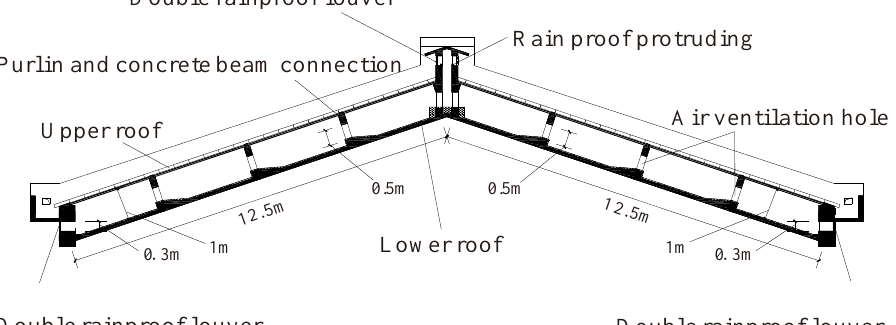
Figure 3. Section plan of double-skin ventilation roof for building. The initial temperature of the roof was the average temperature of the measured roof inner surface temperature for 29 July 2017. Figure 4 shows the measured and predicted inner surface temperatures of the building roofs. The maximum temperature difference and the average temperature difference between the measured and predicted single-skin roof inner surface temperatures were 1.1 ◦ C and 0.33 ◦ C, respectively. The maximum temperature difference and the average temperature difference between the measured and predicted double-skin ventilation roof inner surface temperatures were 0.8 ◦ C and 0.12 ◦ C, respectively. The maximum percentage error between the measured and predicted roof inner surface temperature were 6.7% and 8.2% for the single-skin roof and the double- skin ventilation roof, respectively, which is an acceptable value of prediction accuracy in engineering Measured interior surface temperature of ordinary single-skin roof Predicted interior surface temperature of ordinary single-skin roof Measured interior surface temperature of double-skin ventilation roof Predicted interior surface temperature of double-skin ventilation roof